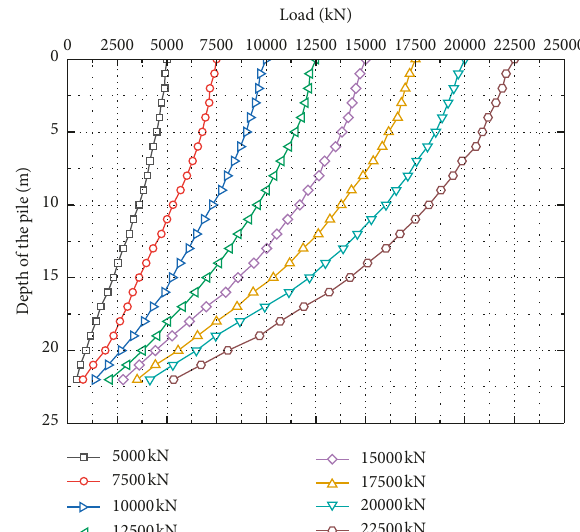
Figure 7: Axial force curve of S2.